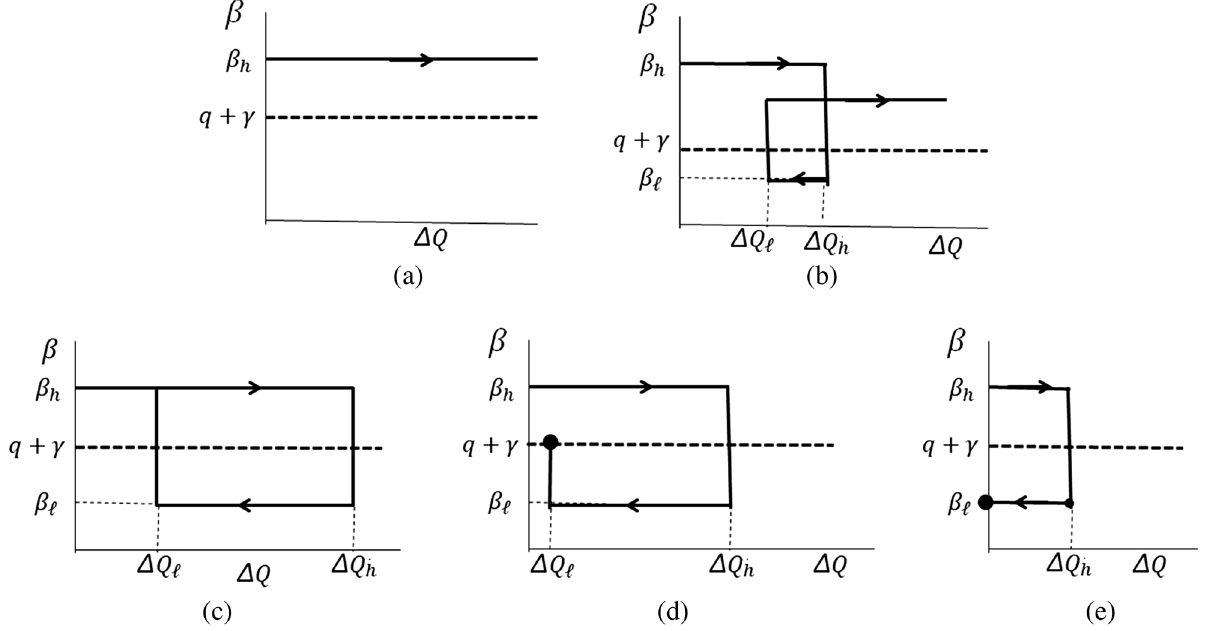
Figure 4. Expected relative magnitude of β (� Q ) and q + γ , which is shown for fixed q + γ . (a) Type I, (b) Type II, (c) Type III, (d) Type IV and (e) Type